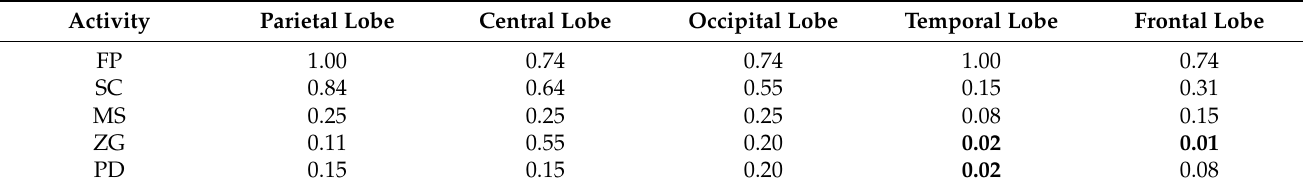
Table 7. Wilcoxon paired test: p -value results of alpha band absolute power between the control test opened eyes (OE) and each of the games (Finger Painting (FP), Sorting Cubes (SC), More Switches (MS), Zero Gravity Switches (ZG), and Punch the Dummy (PD)).